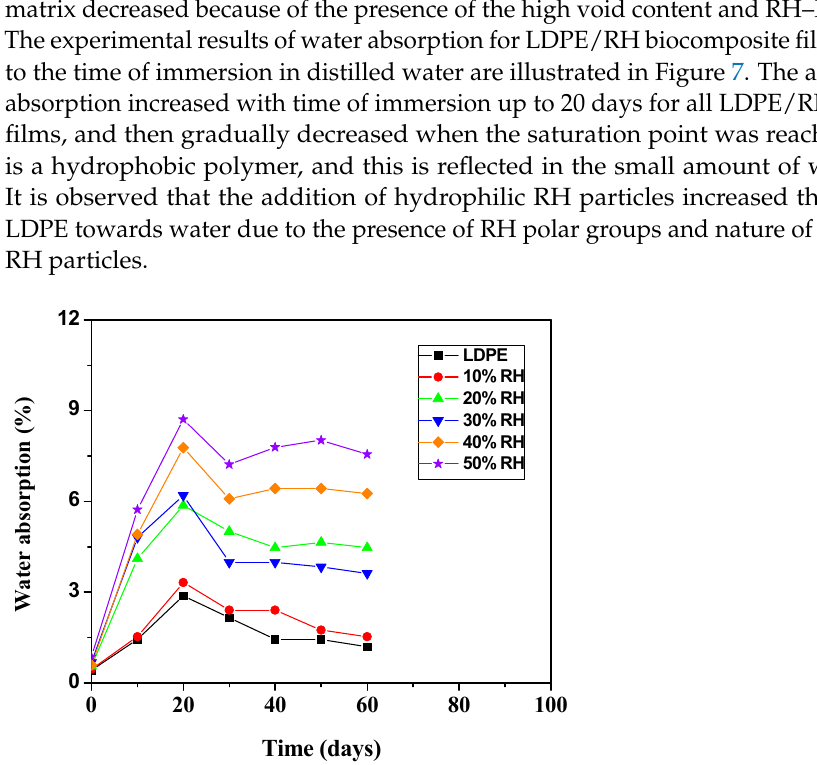
Figure 7. Absorption of water at 60 days immersion in water for LDPE/RH biocomposite films.